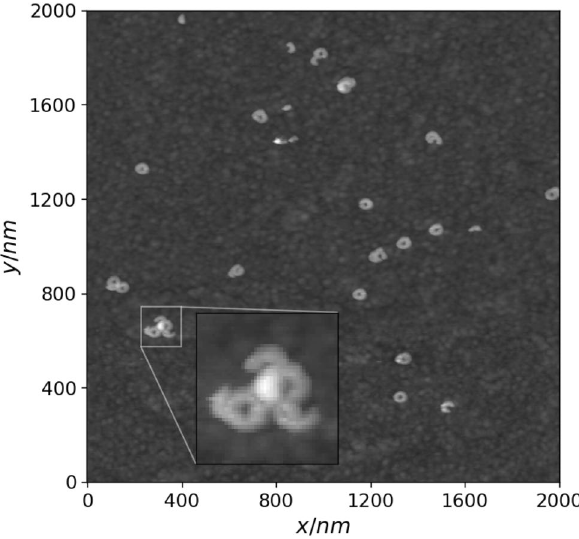
Figure 1. Example of an AFM image fragment with an instance of defect cluster zoomed in.